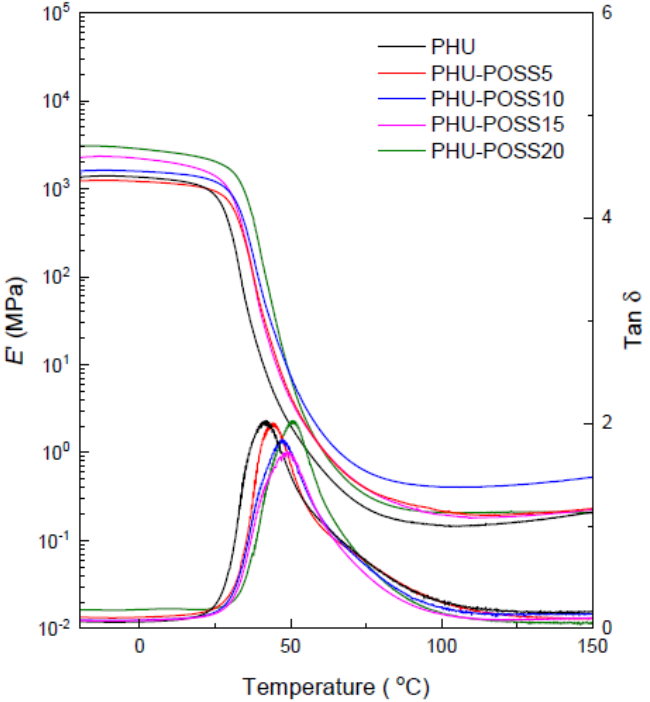
Figure 8. DMTA curves of PHU and PHU-POSS nanocomposites.